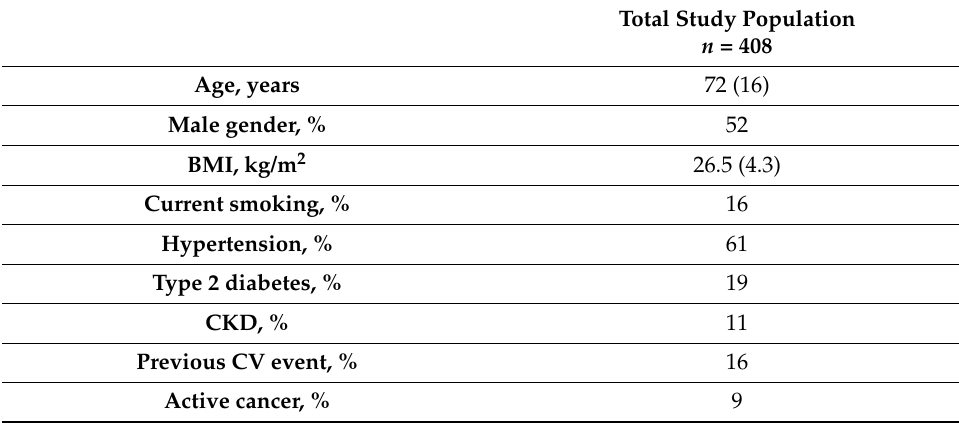
Table 1. Baseline characteristics of the study